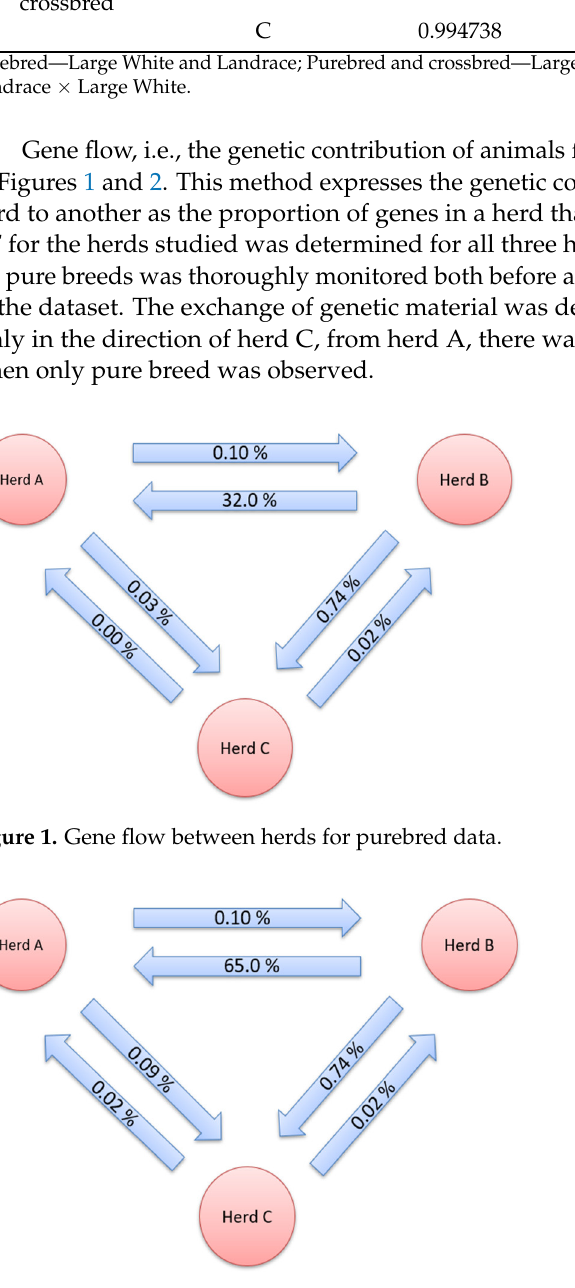
Figure 2. Gene flow between herds for purebred and crossbreed data.